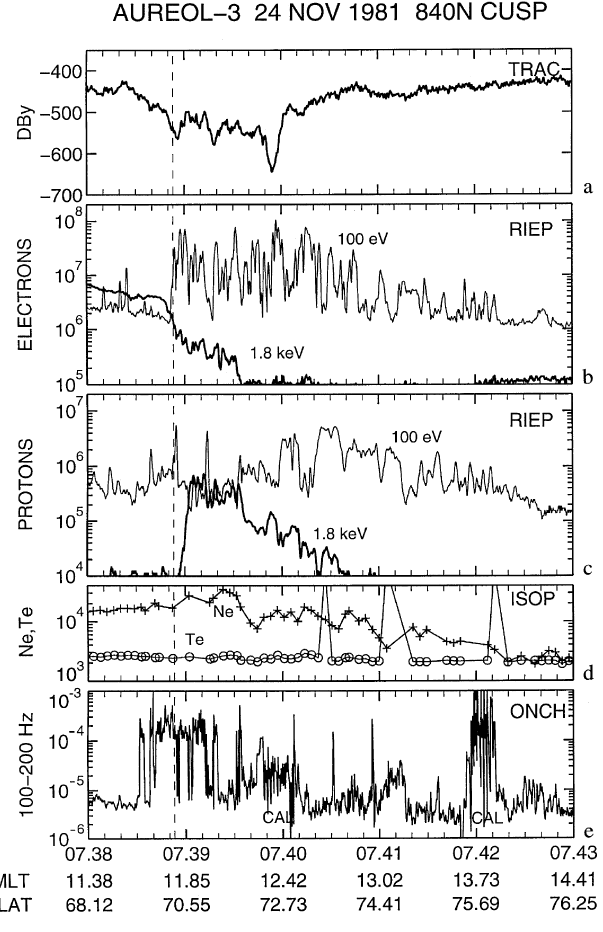
Fig. 2a–e. Overview of AUREOL-3 data for pass 840 North, as a function of time. a The DC magnetic field DB component (nT) y measured by the TRAC instrument; b , c electron and ion fluxes (cm 2 s sr keV) ) 1 in 2 separate energy channels, 0.1 and 1.8 keV (RIEP instrument), sampling rate: 320 ms; d cold electron density N e (cm ) 3 ) and temperature T (K) given by the ISOPROBE instrument e (identical scale); e electric turbulence (TBF instrument) in the 100– 200 Hz frequency range; an onboard instrument calibration period occurred from 0739:43 to 07.40:04